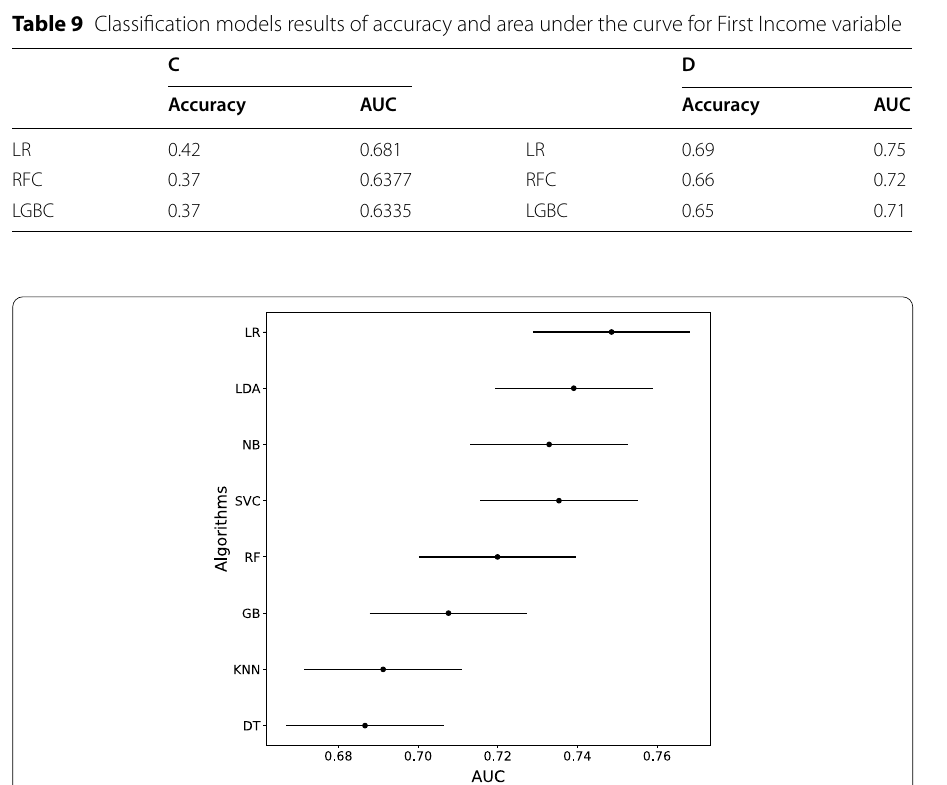
Fig. 12 Tukey HSD Post Hoc Test for the Binary First Income classification models area under the curve